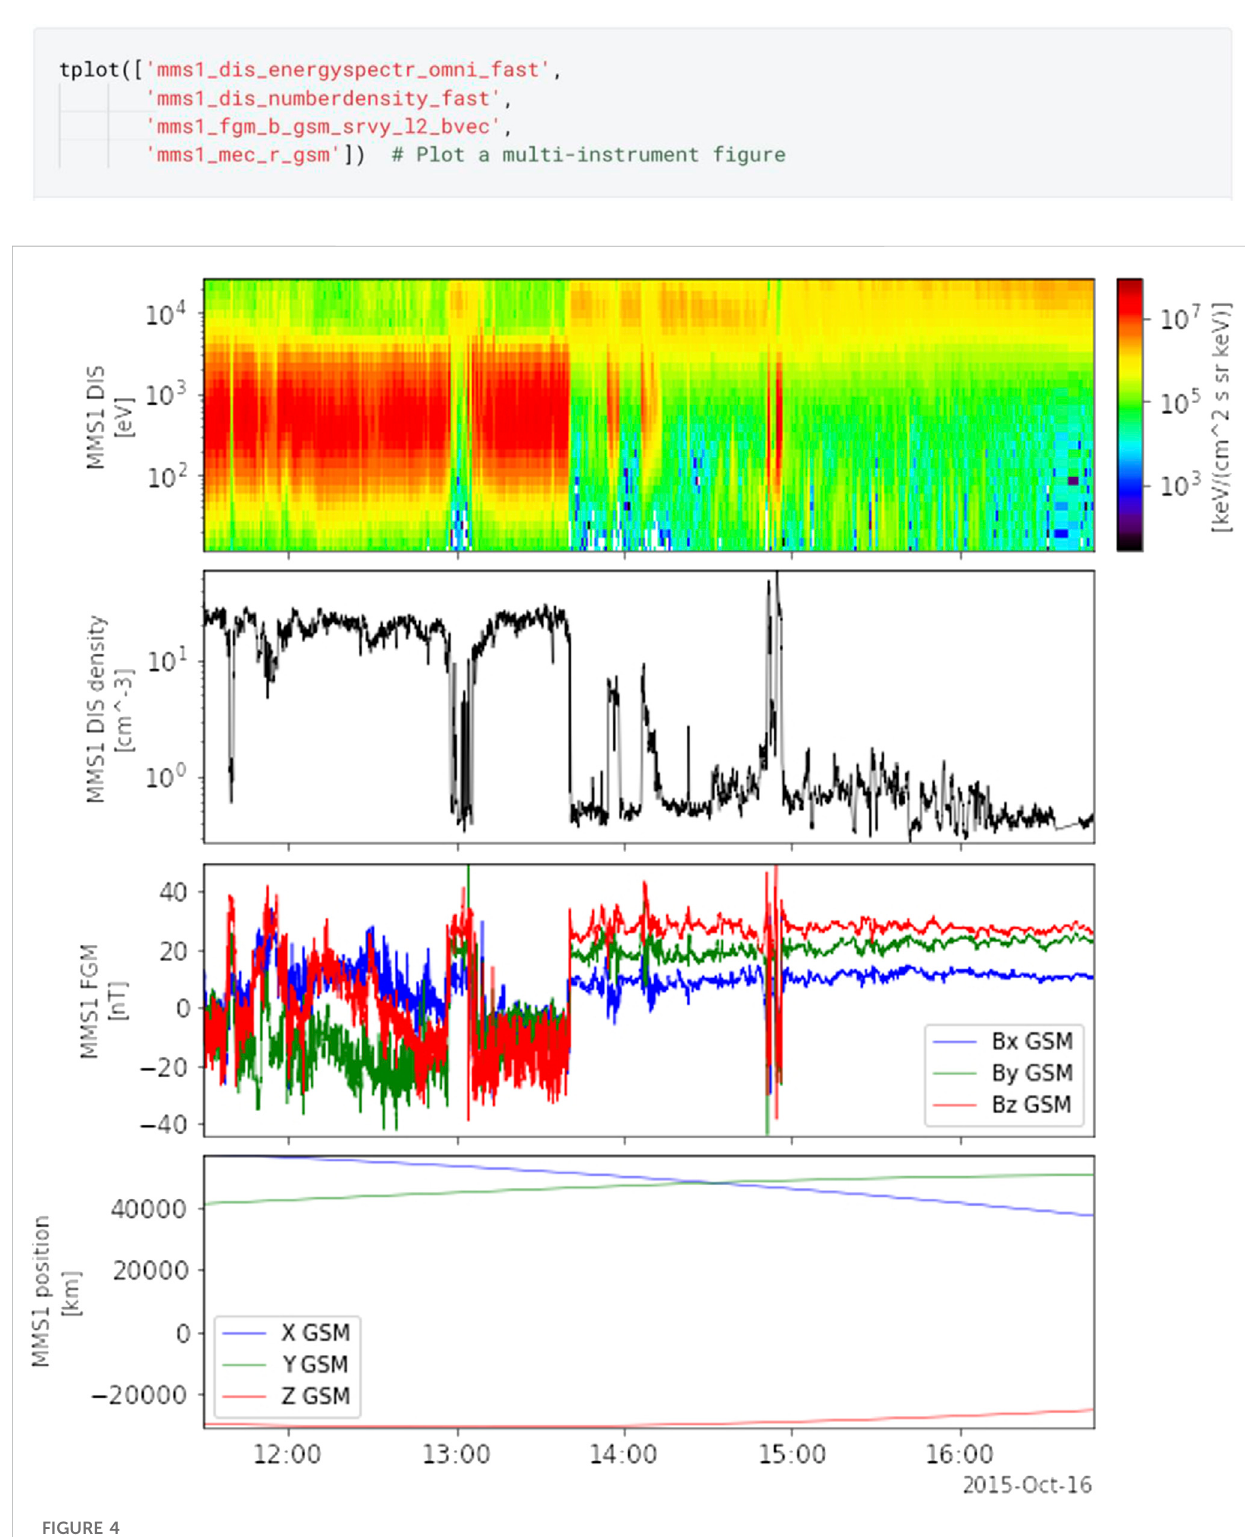
FIGURE 4 Time series plots showing the observed MMS data. Note the dramatic visual changes between 13:00 – 14:00 and the spikes just before 15:00.